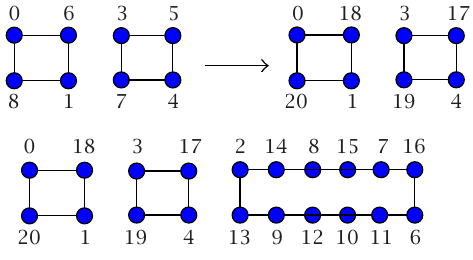
8 to a standard labeling.